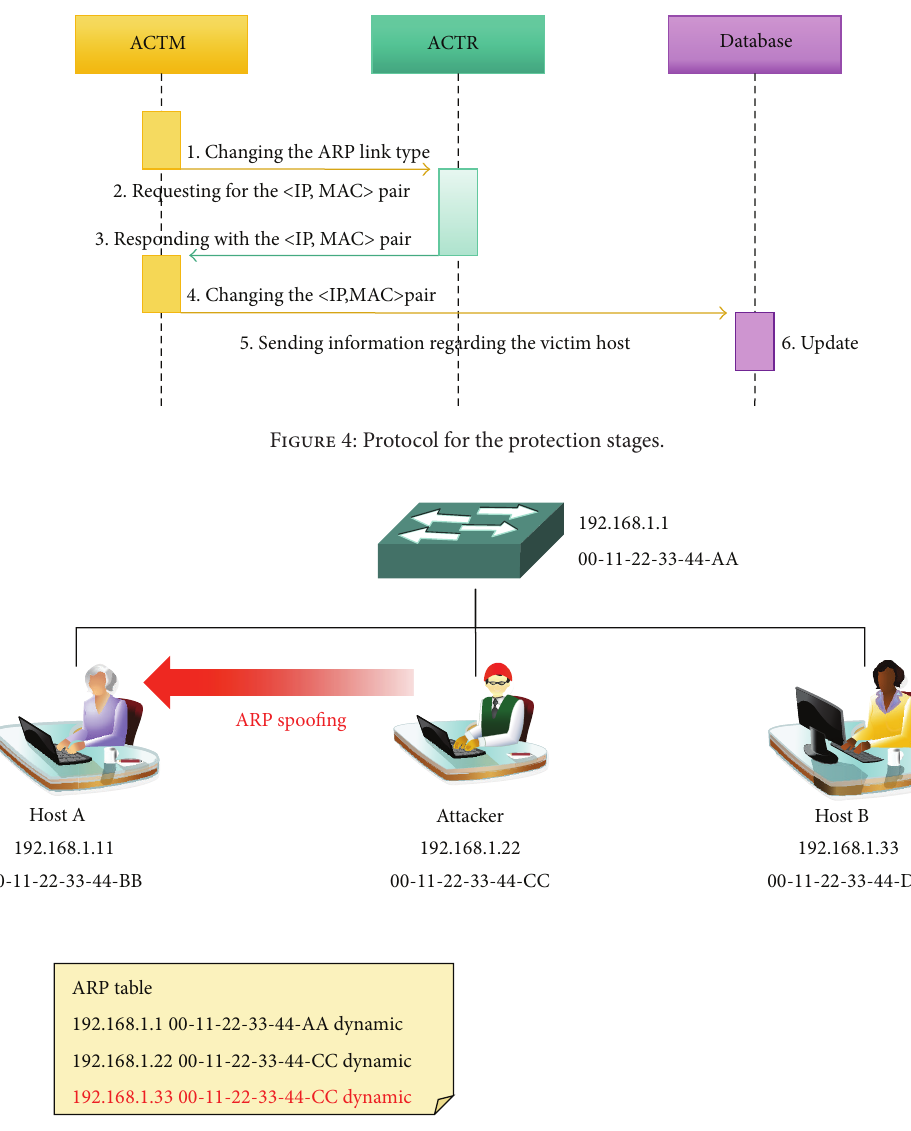
Figure 5: ARP spoofing